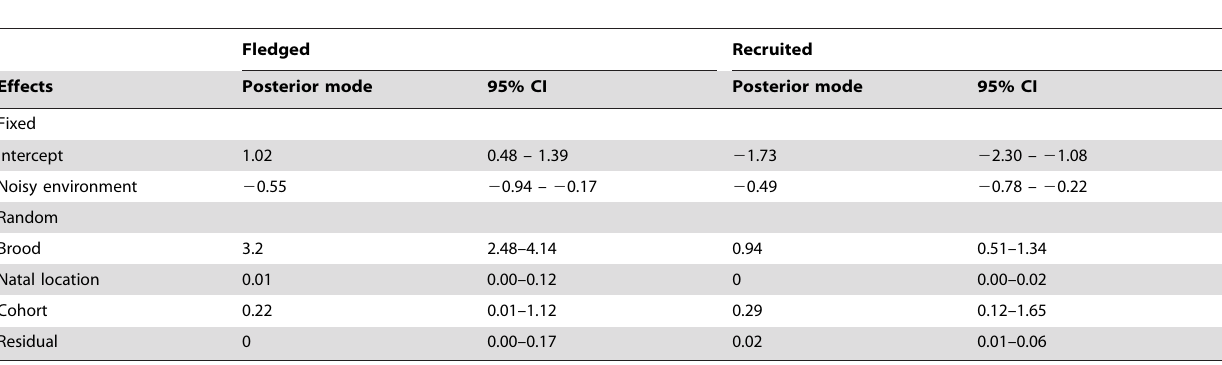
Table 1. Results of a BMM with a logit link function modelling fledging and recruitment probability, of cross-fostered Lundy Island house sparrow chicks as response to noisy and quiet